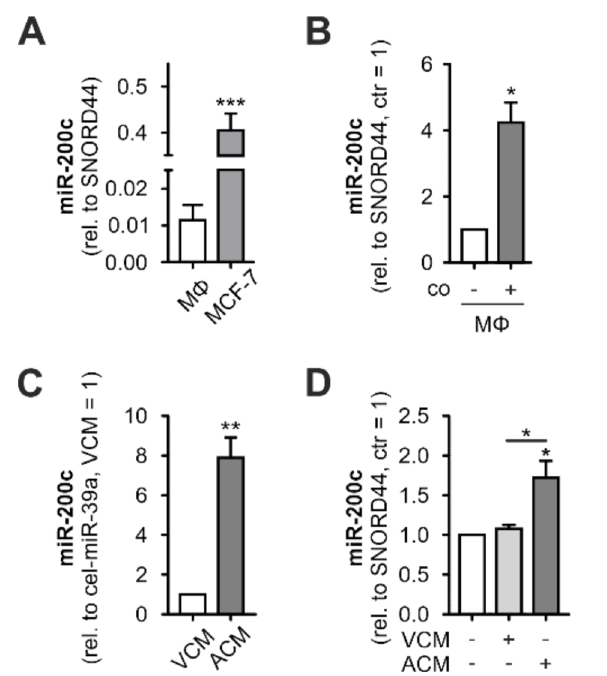
Figure 1. Interaction with apoptotic MCF-7 cells leads to increased miR-200c levels in primary human M Φ . miR-200c levels in ( A ) primary human macrophages (M Φ ) and MCF7 cells, ( B ) M Φ after 48 h coculture (co) with MCF7 cells, ( C ) apoptotic or viable MCF7 cell-conditioned medium (ACM/VCM), and ( D ) M Φ 24 h after treatment with ACM/VCM (1 h). miR-200c levels were determined using qPCR and normalized to either SNORD44 (cellular levels) or spiked-in cel-miR-39a (CM). Data are depicted as mean ± SEM ( n ≥ 4; * p < 0.05, ** p < 0.01, *** p <